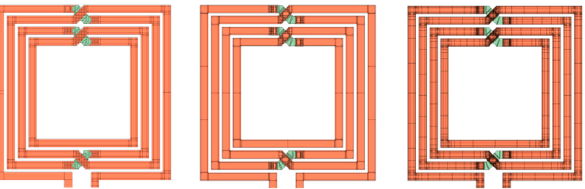
Figure 2. Examples of EM models of graduated complexity of a rectangular 4-turn, 1-layer coil. From left to right: coarse model without edge meshing, routed on a 2 × 2 grid; coarse model with edge meshing on a 1 × 1 grid, and fine model created on a 0.5 × 0.5 grid. Grid dimensions are in